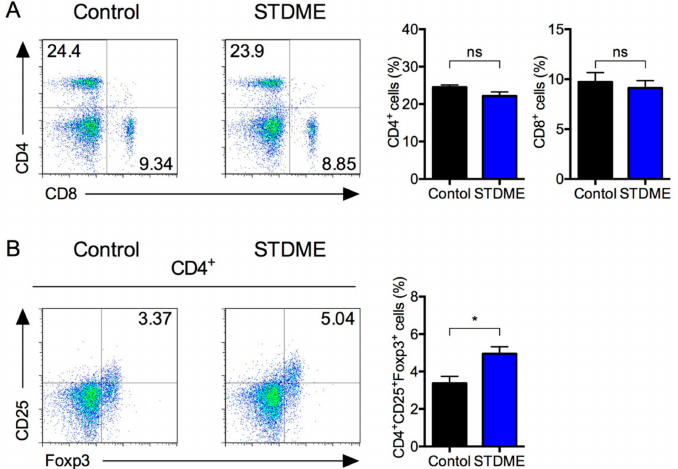
Figure 4. Splenic T cell subsets in STDME-fed mice after induction of AOM/DSS-induced CAC. Splenocytes from control or STDME-fed CAC-induced mice were isolated. Representative dot plot of CD4 + , CD8 + and CD4 + CD25 + Foxp3 + splenocytes analyzed by flow cytometry. Each bar represents the mean ± SEM and the data were assessed by a Mann-Whitney U -test. * p < 0.05; ns = not significant; n = 10/group. STDME, selenoneine-containing tuna dark muscle